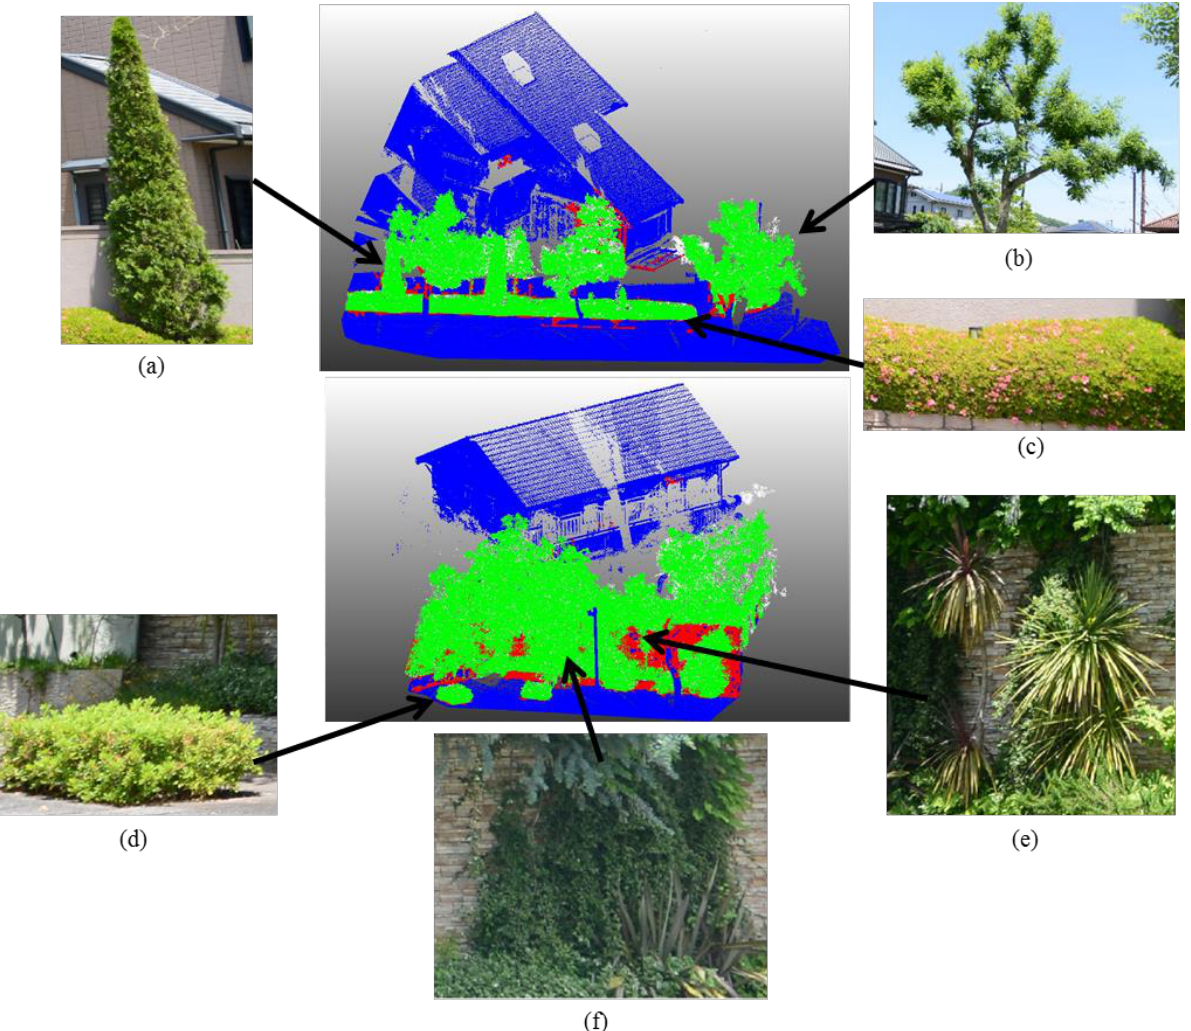
Figure 10. Vegetation extracted by the proposed method. (a), (c), (d) Trimmed vegetation, (b) canopy of the tree. (e) shrub with the needle leaves and (f)